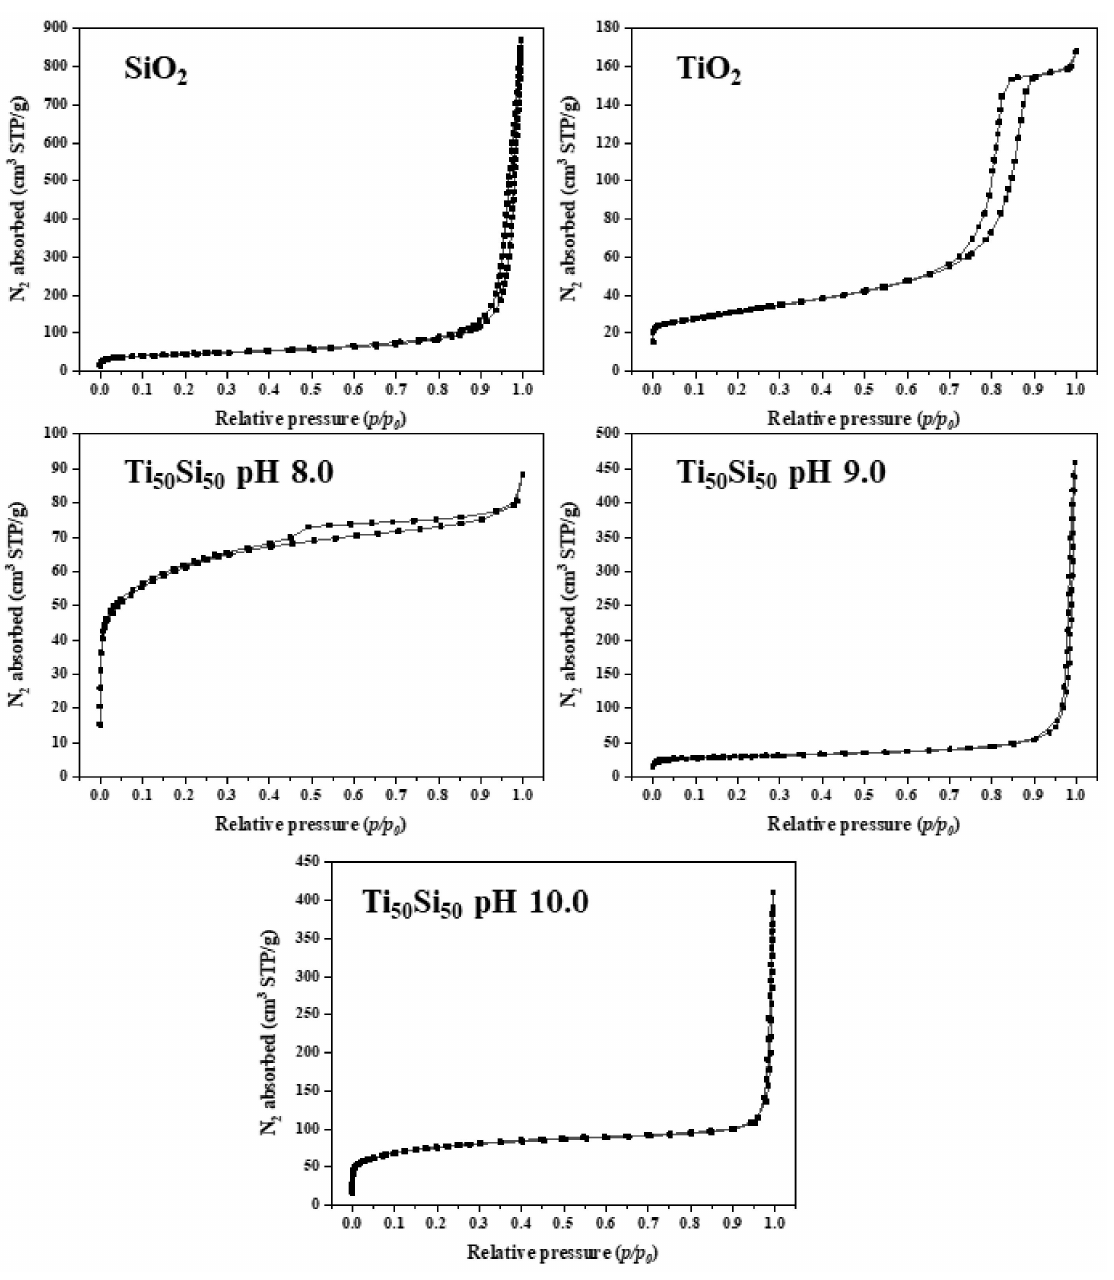
Figure 13. Nitrogen adsorption–desorption isotherms of SiO 2 , TiO 2 , and Ti 50 Si 50 oxide synthesized at various pH